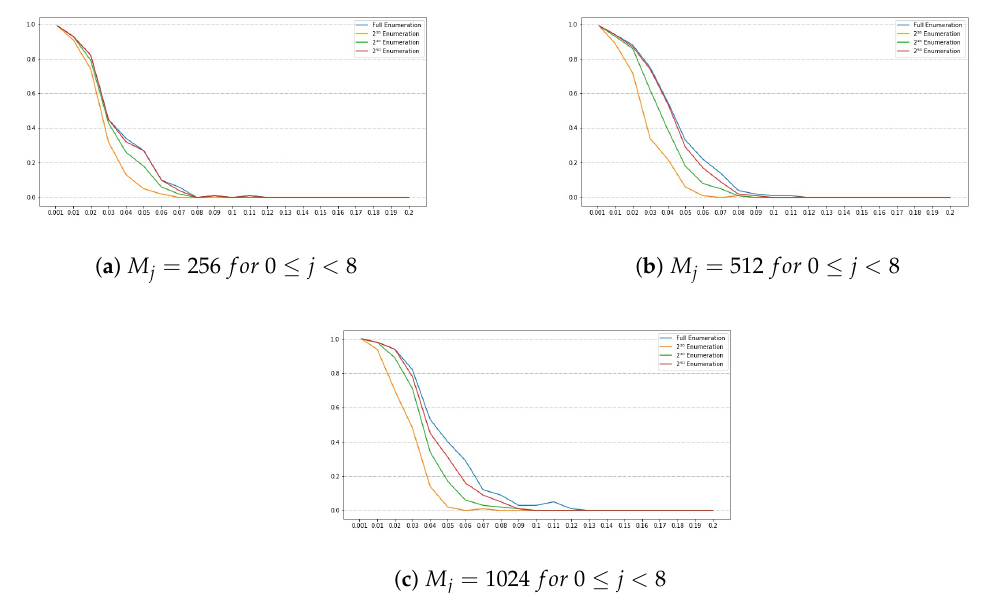
Figure 7. Success rate for the SIKE parameters SIKEp751 for α = 0.001. The y -axis denotes the success rate, while the x -axis denotes β